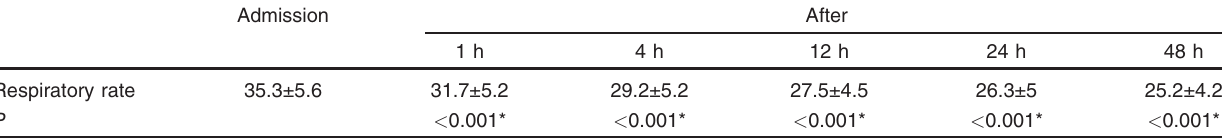
Table 10 Improvement of respiratory rate in successful cases of group II ( n = 19) at different studied periods